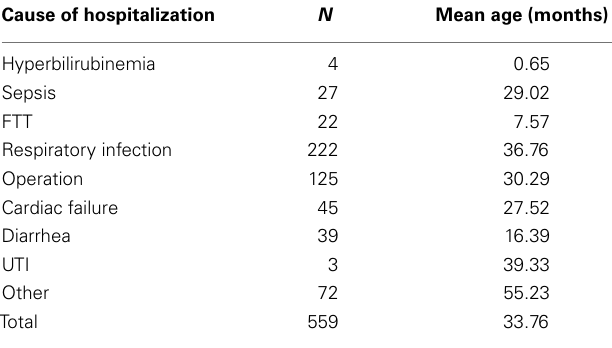
Table 2 | Causes of hospitalization by age.